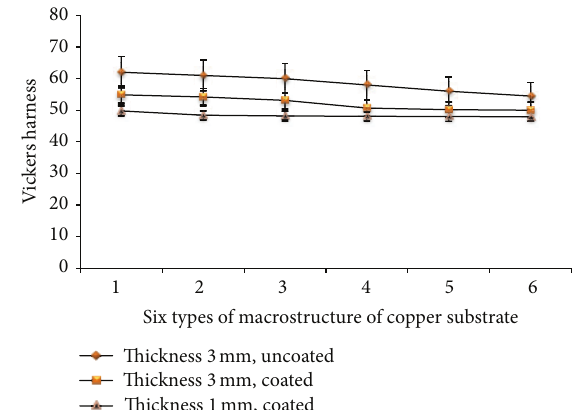
Figure 8: SEM image of AZ31-B strip.